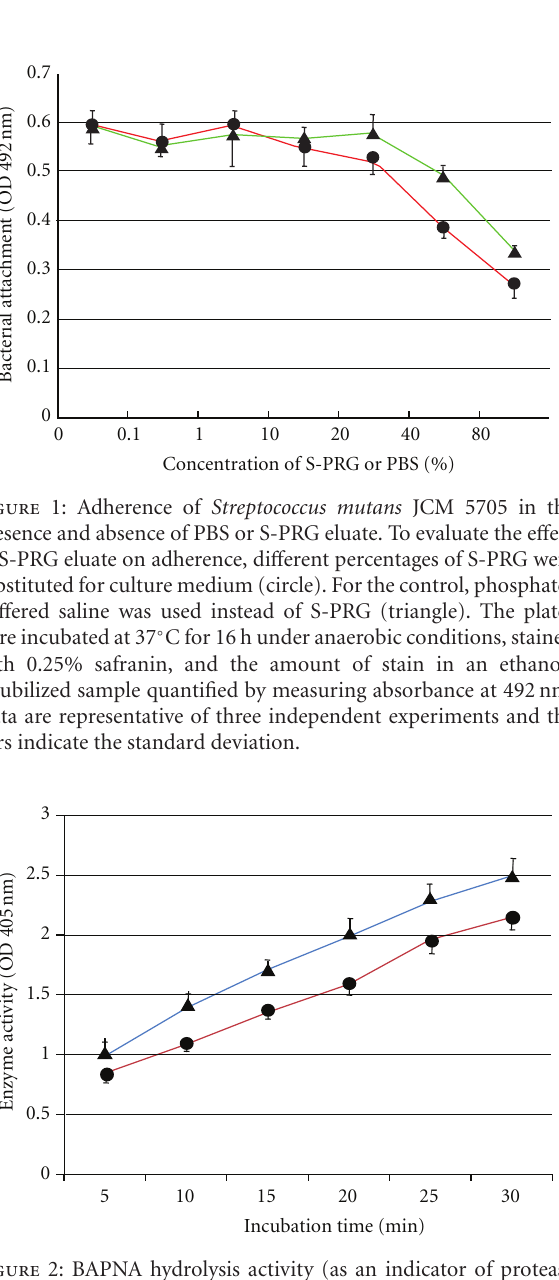
Figure 2: BAPNA hydrolysis activity (as an indicator of protease activity) in the presence and absence of S-PRG eluate. P.-gingivalis- sonicated extract was added to the reaction mixture. To analyze the e ff ect of S-PRG, distilled water in control mixture (triangle) was replaced with S-PRG solution (circle). Colored metabolites were quantified using a colorimetric absorbance assay at 405 nm. Data are representative of three independent experiments and the bars indicate the standard